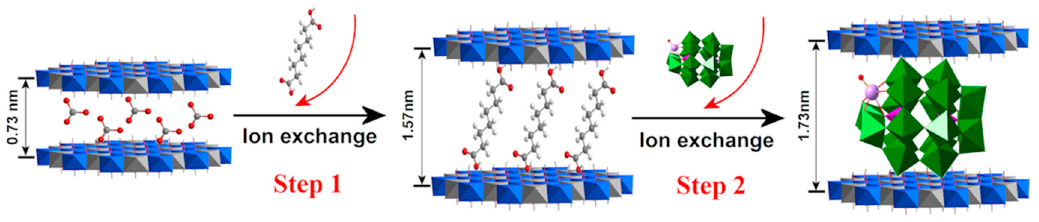
Figure 6. Schematic of the synthesis of [ α 2 ‐ P 2 W 17 O 61 (X ∙ OH 2 )] n − intercalated into LDHs. Adapted from Ref. [36], Copyright 2015, American Chemical Society.